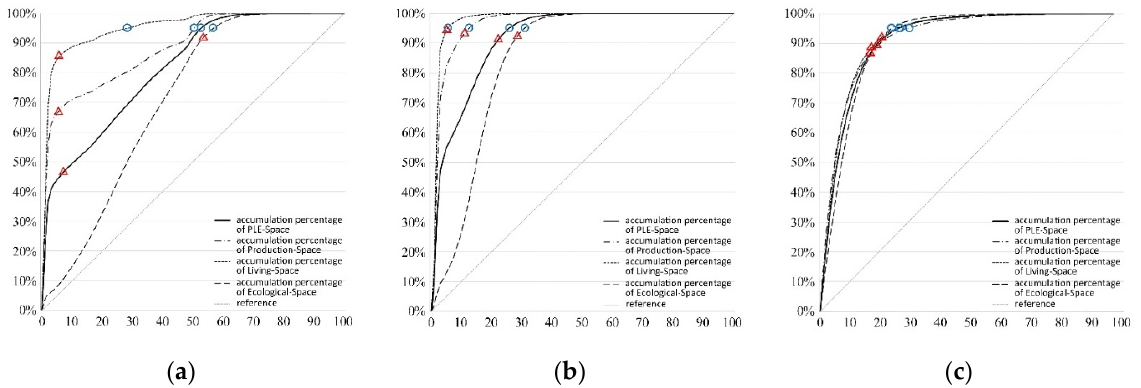
Figure 5. PLES cumulative curves of natural factors. ( a ) Elevation; ( b ) relief intensity; ( c ) distance to water.